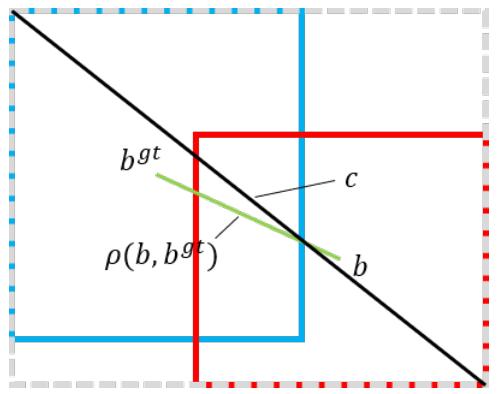
Figure 10. Calculation of DIoU. b gt is the centroid of the ground-truth box, b is the centroid of the prediction box, the green line is ρ ( b , b gt ) , and the black line is c